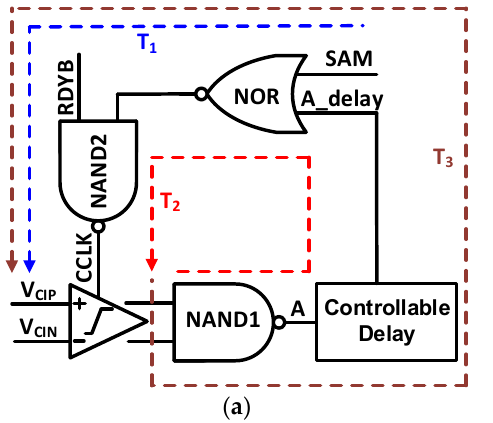
Figure 10. SAR logic block diagram.